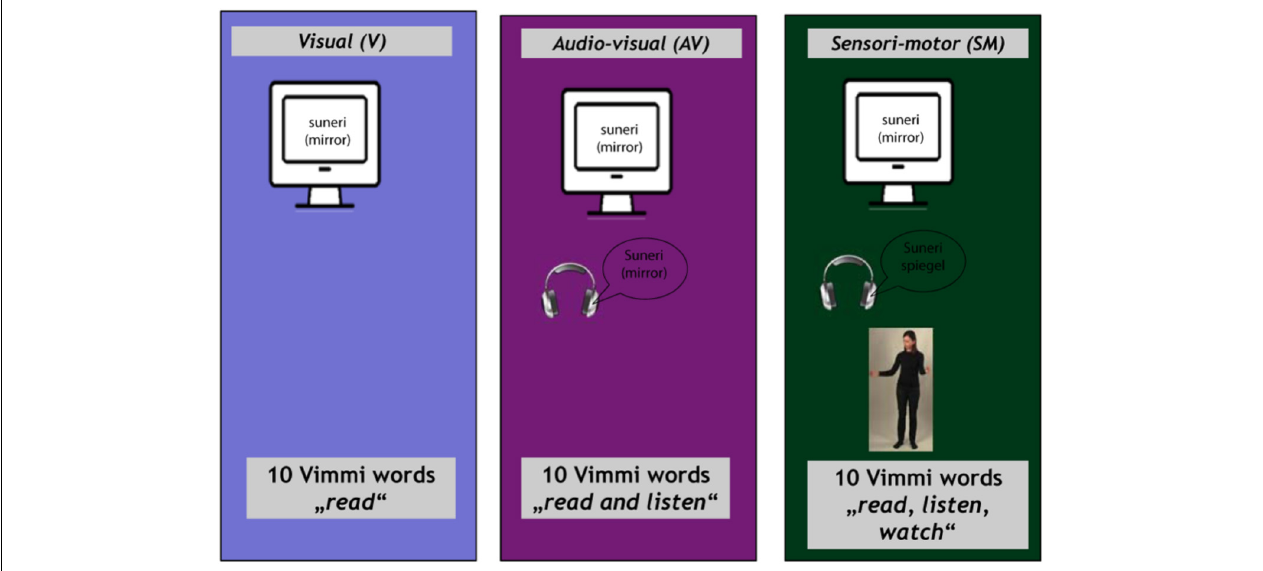
FIGURE 2 | Training conditions in the scanner with